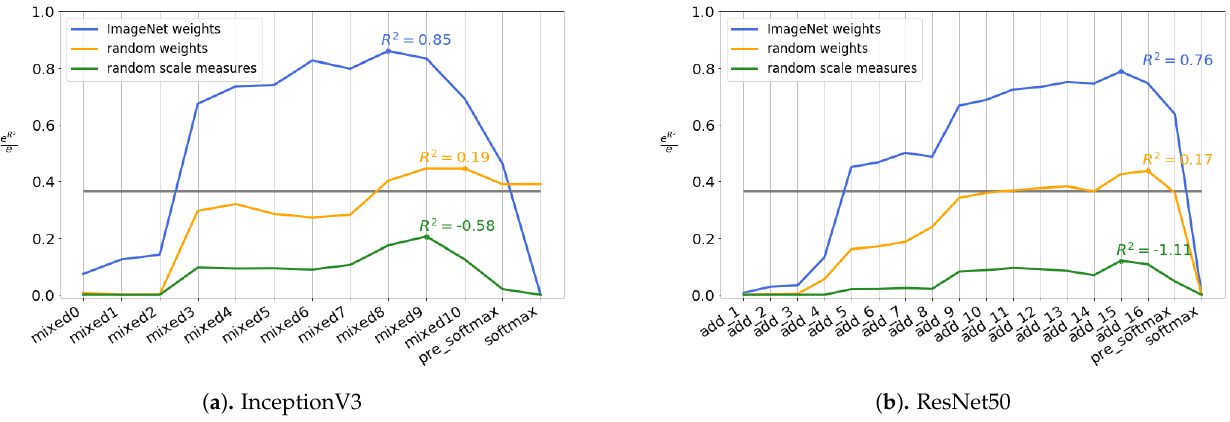
Figure A2. Average performance (for all classes) of the regression of scale measures on test data at different